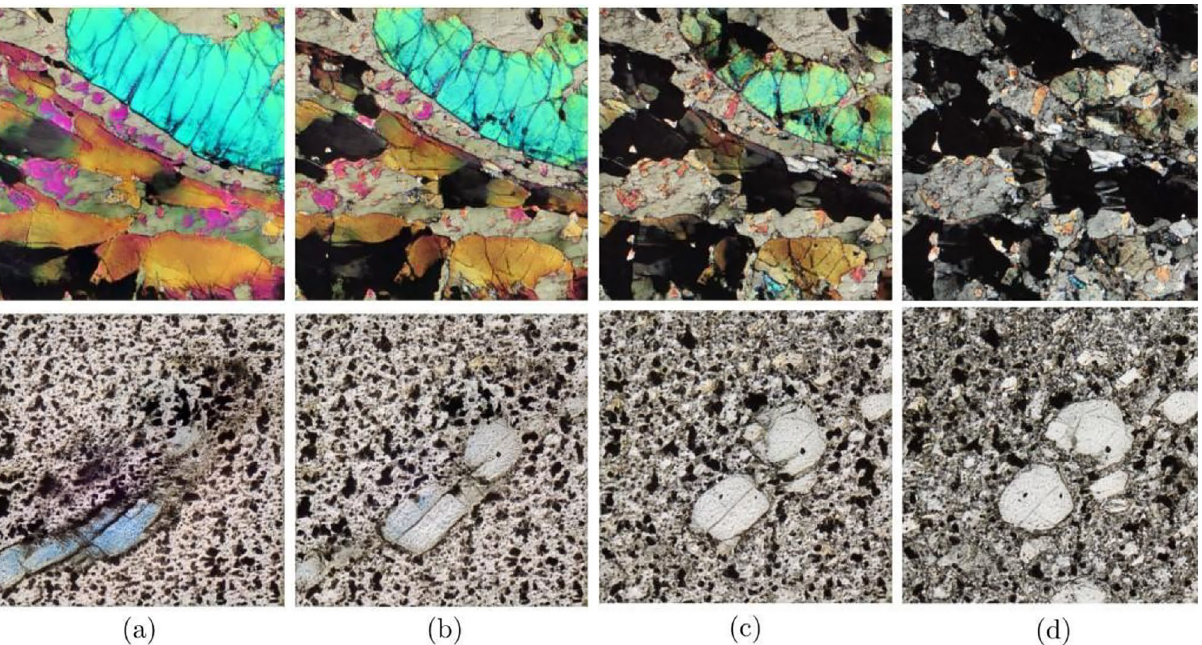
Figure 9. Results of applying truncation to two generated images show a progressive change in truncation and its effects, with ( a ) 1.25, ( b ) 1.0, ( c ) 0.75, ( d ) 0.5 as truncation values.